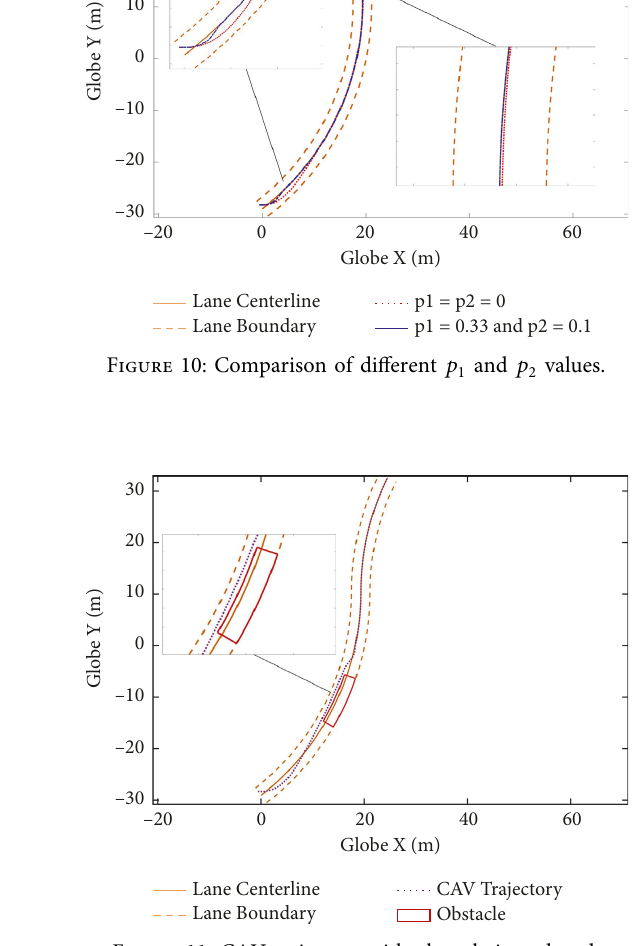
Figure 11: CAV trajectory with obstacle